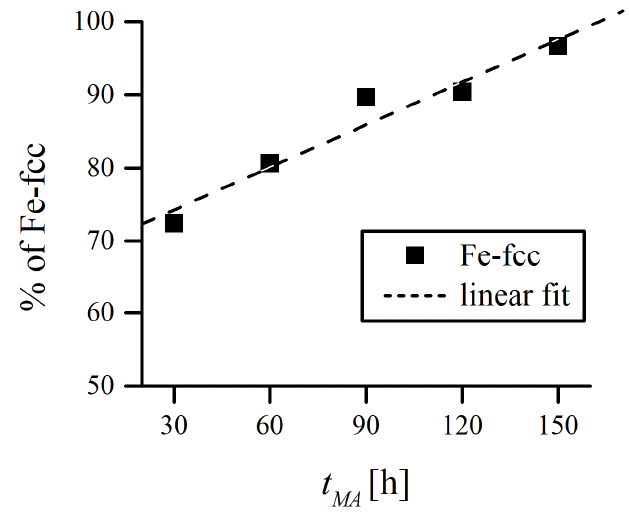
Figure 6. Phase percentage of Fe-fcc.